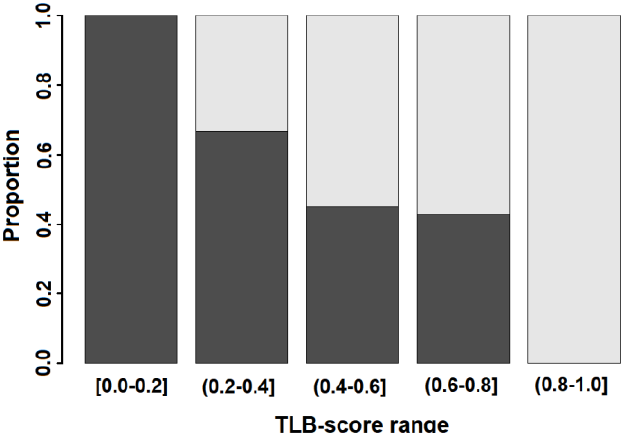
Figure 6. Proportion of subjects from HC subjects (dark grey) and MS patients (light grey) according to the TLB